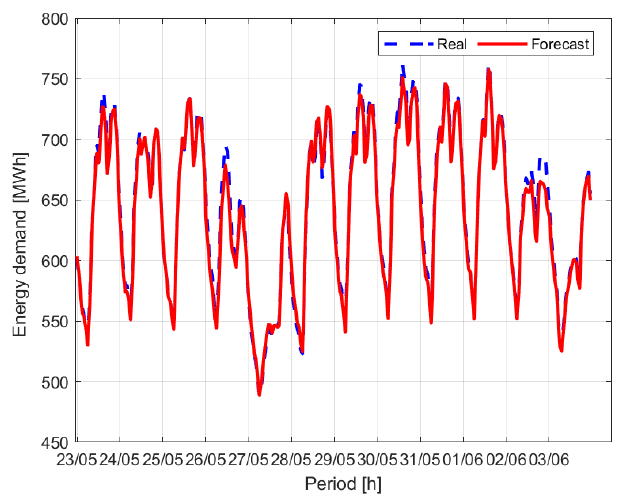
2020 , 13 , x FOR PEER REVIEW